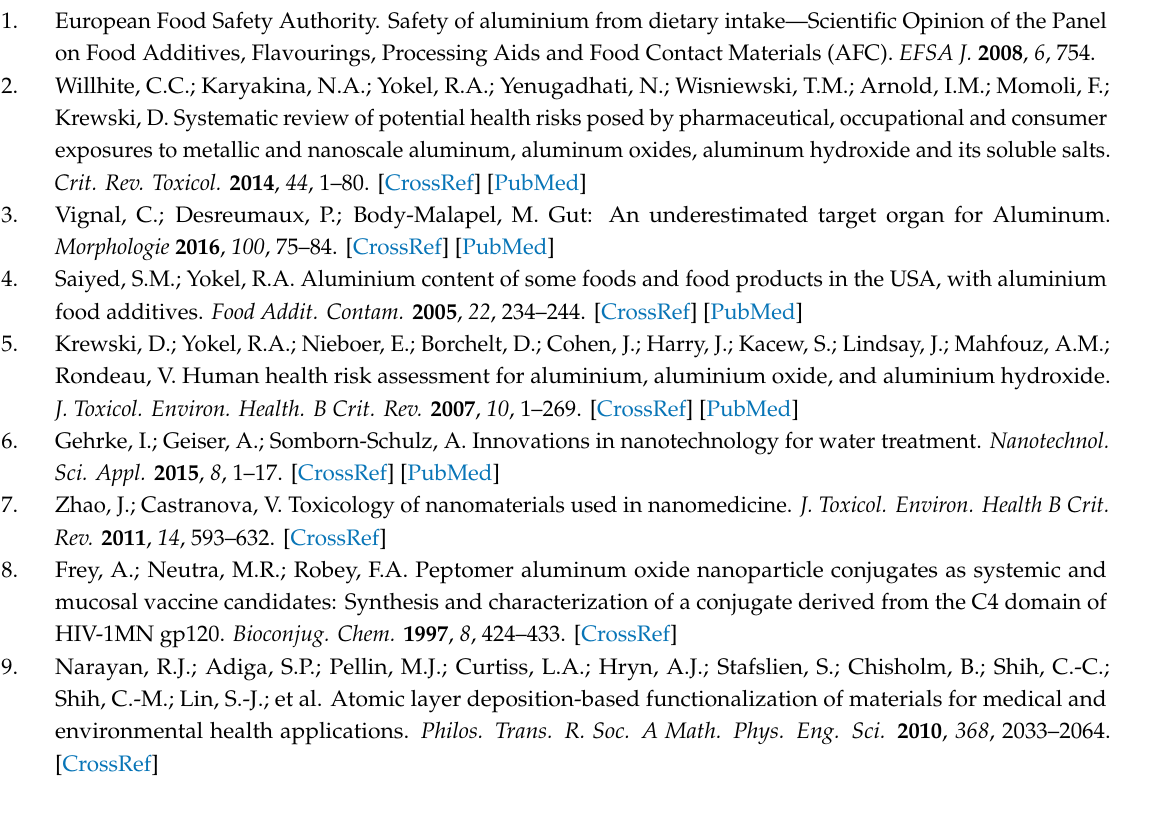
Figure S1: Equivalence between the doses administrated between mass and Al content., Table S1: Percentage of hedgehogs scored on the comet slides without Fpg. Mean ± SD (n = 5 animals per condition except for control duodenum n = 4)., Table S2: Percentage of hedgehogs scored on the comet slides with Fpg. Mean ± SD (n = 5 animals per